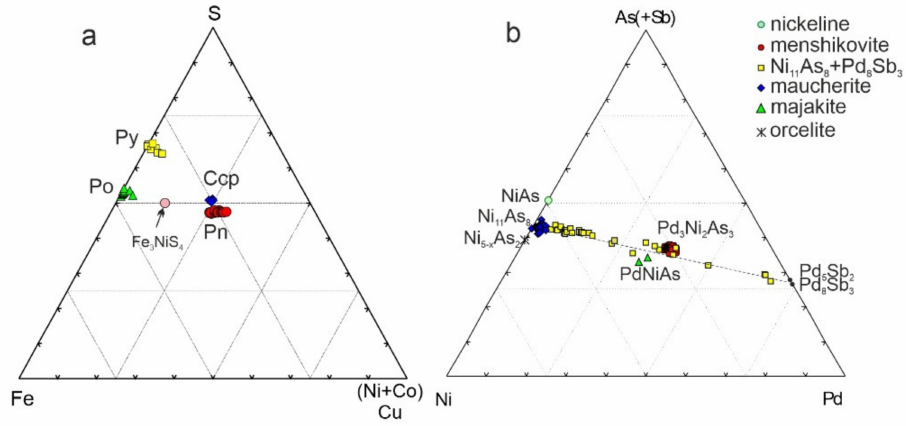
Figure 5. Compositions of sulfides ( a ) and minerals of the Pd–Ni–As(Sb) system ( b ) from the Skalisty